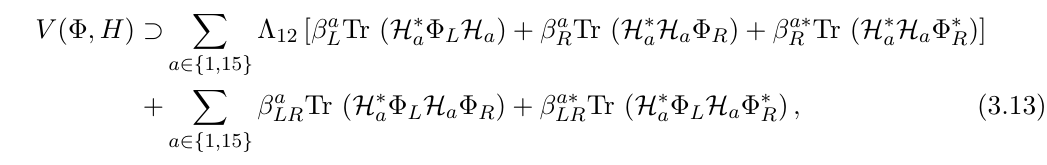
Figure 3 . Feynman diagrams that contribute to the 1–2 (left) and 2–1 (right) elements of the Yukawa matrices, once the heavy Higgs components running along the internal lines are integrated out at Λ 12